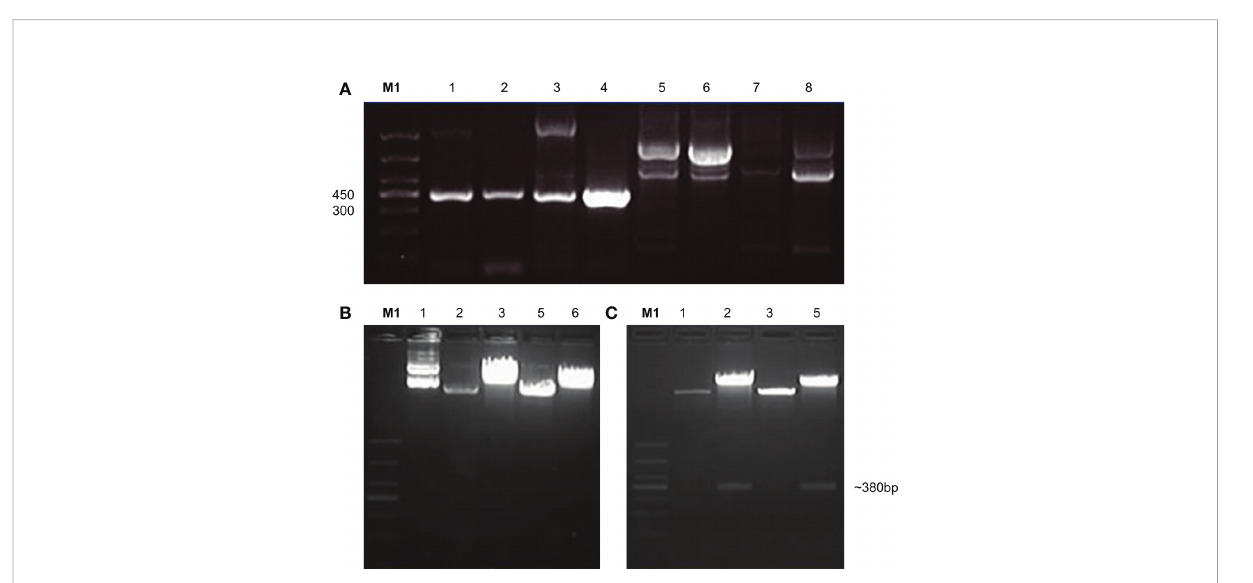
FIGURE 3 Con fi rmation of variable regions by PCR and enzyme activity of light chain. (A) indicates PCR con fi rmation of variable recombinant. Lanes 1-4 showed positive results and lanes 5-8 were declared negative. The positive products were further analyzed by double enzyme digestion. (B) shows the activity of EcoRI enzyme which was recorded as the fi rst enzyme, (C) shows the second enzyme BsiwI restriction enzyme